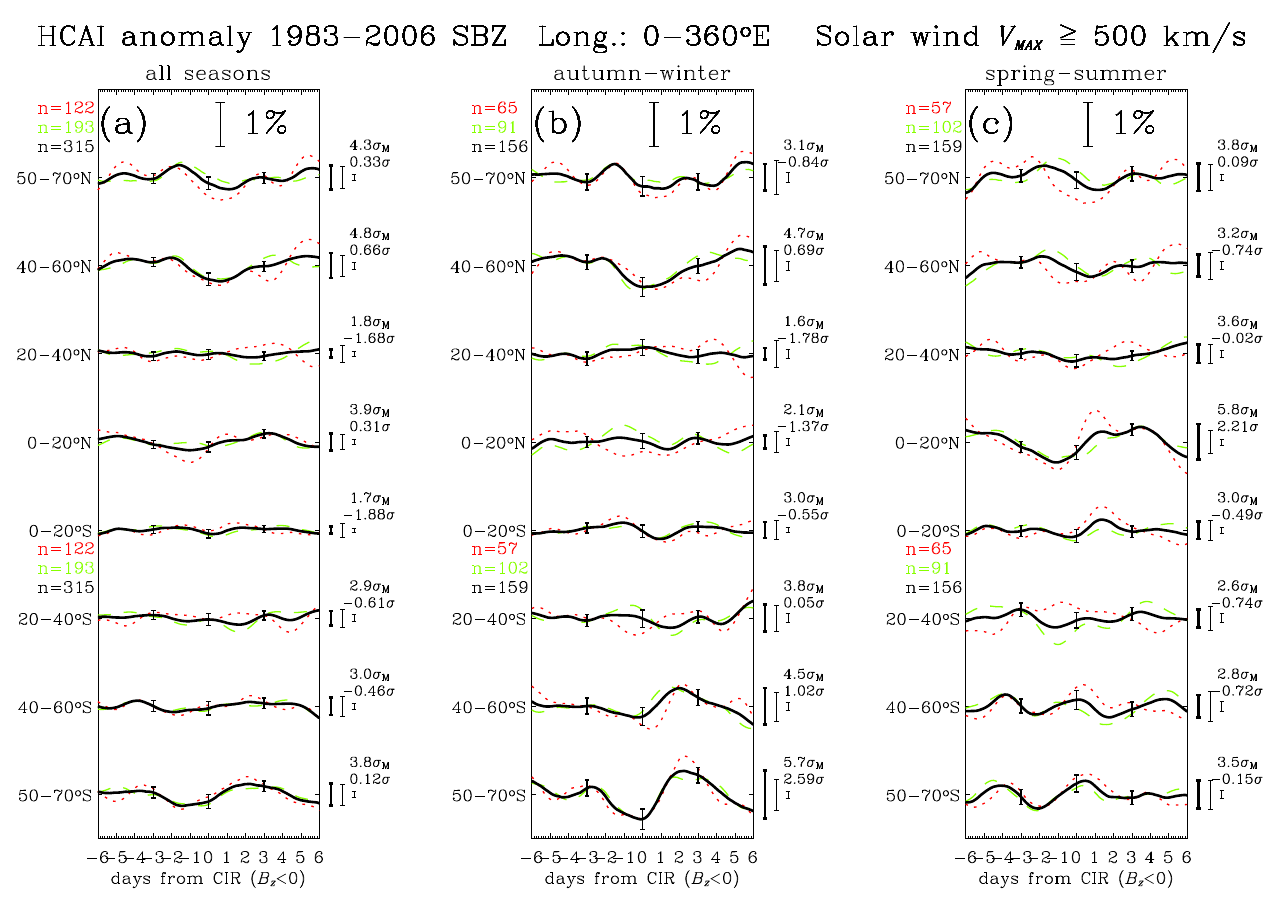
< 0). Fig. 13. The same as Fig. 12 but for SBZ events (IMF B Z < Z